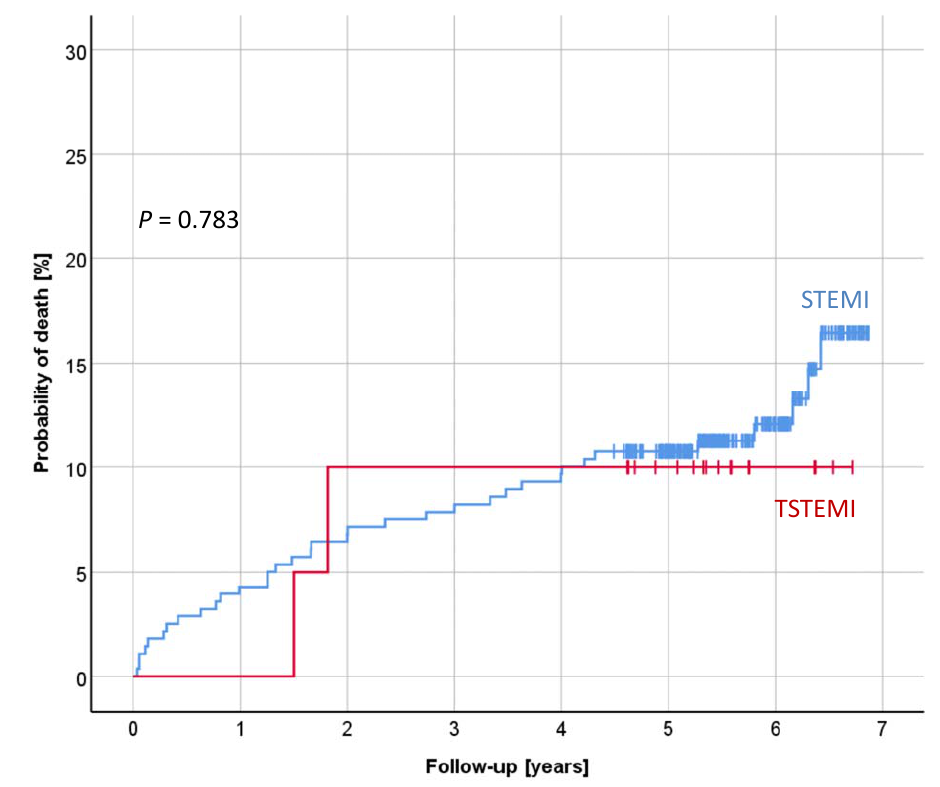
Fig. 2. Kaplan-Meier analysis of probabilities of death in patients with a pre-PPCI TIMI flow grade 0, 1, and 2 (red line) and those with pre-PPCI TIMI flow grade 3 (blue line). Crosses of the survival Fig. 1. Kaplan-Meier analysis of probabilities of death in TSTEMI (red line) and STEMI (blue line) patients. Crosses of the survival curves indicate censored cases. curves indicate censored cases.